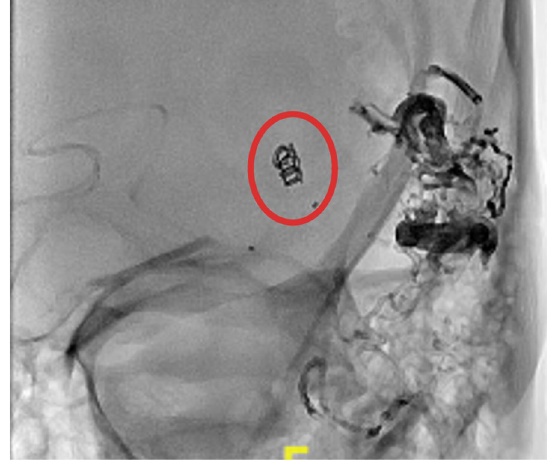
Fig. 6 Angiographic imaging of positioning the coil wedge, AP